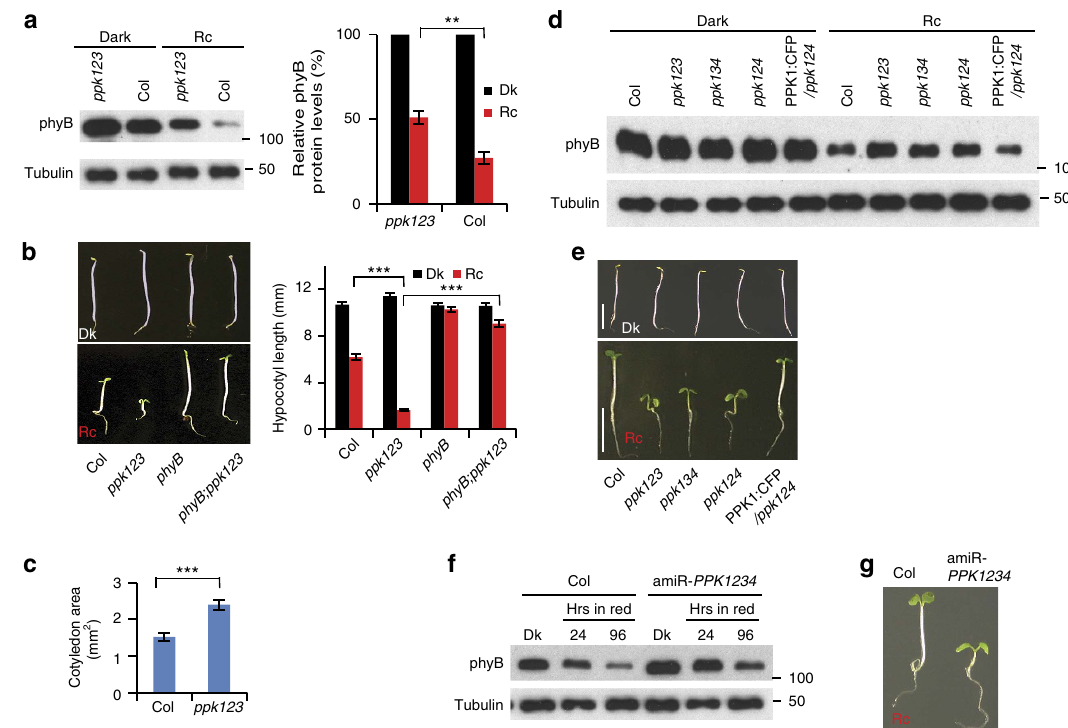
Figure 3 | PPKs function collectively in promoting light-induced phyB degradation. ( a ) Light-induced degradation of phyB is reduced in the ppk123 mutant. Seedlings were grown either in the dark (Dk) or continuous red right (Rc) for 4 days before protein extraction and immunoblot analysis using either anti-phyB antibody, or anti-tubulin as a loading control (left panel). Right panel shows quantification of the phyB levels relative to the tubulin protein levels from three biological replicates, expressed as a percentage of the dark-seedling levels for each genotype. Error bars represent s.e. ** P o 0.01 (Student’s t -test). ( b ) A phyB null mutation suppresses the hypersensitive, short-hypocotyl phenotype of the ppk123 mutant in the light ( phyB:ppk123 ). Average hypocotyl lengths of 4-day Dk- or Rc-grown seedlings are shown at right. Error bars represent s.e. from three biological replicates. *** P o 0.001 (Student’s t -test). ( c ) The light-hypersensitive phenotype of the ppk123 triple mutant includes enhanced cotyledon expansion compared to WT. Error bars represent s.e. from three biological replicates. *** P o 0.001 (Student’s t -test). ( d ) PPK1, PPK2, PPK3 and PPK4 are collectively necessary for normal PIF3 promoted phyB degradation in the light. Light-induced degradation of phyB is reduced in the ppk123, ppk134 and ppk124 triple-mutant backgrounds, and this reduced phyB degradation in the ppk124 triple-mutant can be rescued by transgenic expression of PPK1:CFP (PPK1:CFP/ ppk124 ). Seedlings of the indicated genotypes were grown for 4 days in the dark or continuous red light (Rc) before protein extraction and western blot analysis using an anti-phyB antibody, or anti-tubulin as a loading control. ( e ) PPKs are collectively necessary for normal hypocotyl responsiveness to light. Seedlings of the indicated genotypes were grown as in d . Scale bars, 5mm. ( f ) Light-induced degradation of phyB is reduced in the amiR- PPK1234 line. Seedling growth and western blot were done as in d . ( g ) The amiR- PPK1234 line is hypersensitive to red light. Seedlings were grown for 4 days in red